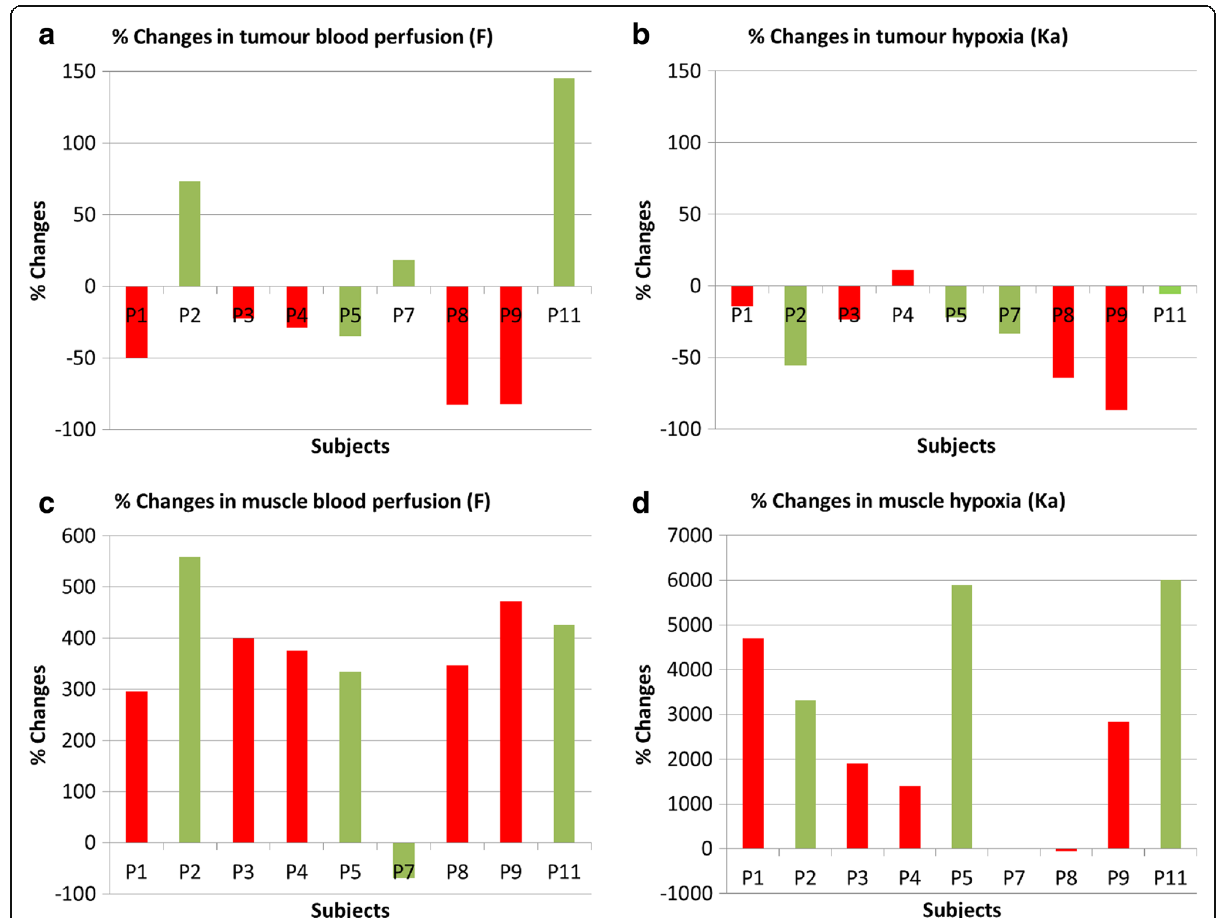
Fig. 2 Percentage changes in tumour blood perfusion ( a ), tumour hypoxia ( b ), muscle blood perfusion ( c ) and muscle hypoxia ( d ) between baseline and after 8 – 10 fractions of CRT from fitting 0-45 min [ 18 F]FMISO PET data to Casciari model. The red bars show non-responders and the green bars show responders. [ 18 F]FMISO = [ 18 F]fluoromisonidazole; PET = positron emission tomography; CRT = chemoradiotherapy; % = percentage; min =